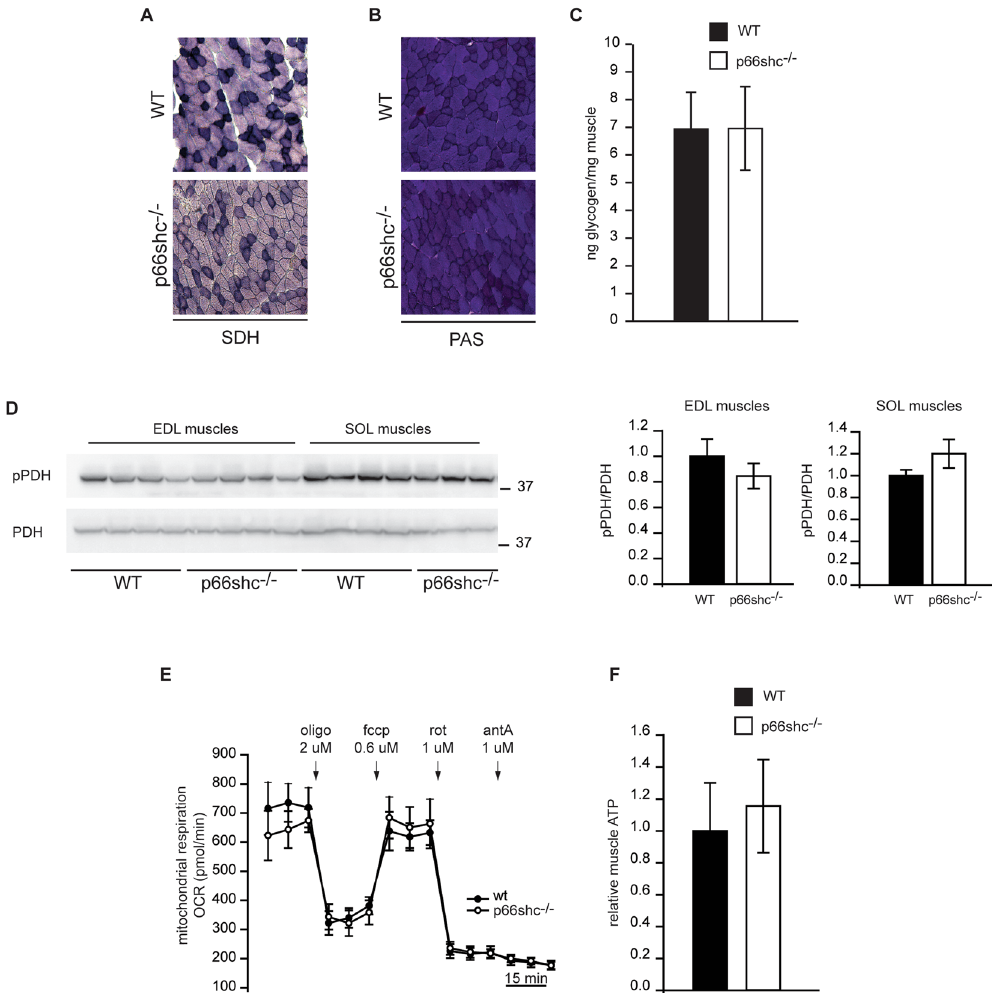
Figure 2. Metabolic parameters of p66shc − / − muscles. ( A ) Succinyl-Dehydrogenase (SDH) activity assay of wt and p66shc − / − TA muscles. ( B ) Periodic Acid–Schiff (PAS) staining for glycogen content. ( C ) Glycogen quantification of wt and p66shc − / − muscles mice. Data are presented as mean ± SEM (3 animals per group). ( D ) Phosphorylation levels of PDH in EDL and soleus (SOL) muscles and quantification by densitometry. Data are presented as mean ± SEM (5 animals per group). Cropped blots are displayed, and full-length blots are presented in Supplementary Figure S1. ( E ) OCR rate measurements in adult myofibers. Data are presented as mean ± SEM (3 animals per group). ( F ) ATP measurements in muscle homogenates. Data are presented as mean ± SEM (5 animals per